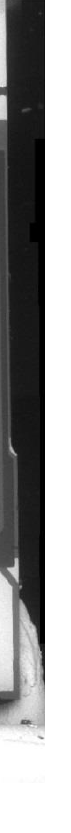
Figure 17. Thickness measurements from an SEM image. ( a ) The top view of the QTF. ( b ). The side view of the QTF.